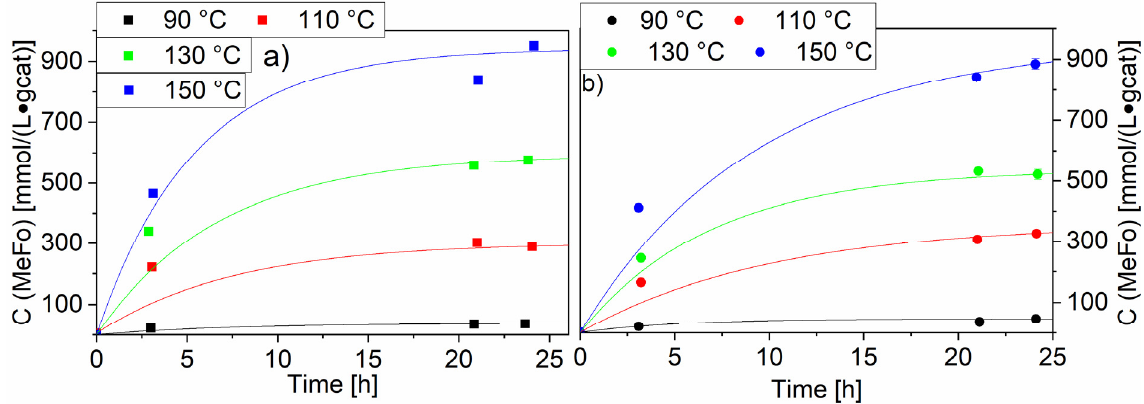
Figure 9. Impact of the temperature on the methyl formate productivity with Ru-NO-5-icr. and Ru-Cl-5-icr. used as catalysts. Graph ( a ) shows the MeFo concentration for the Ru-NO-5-icr. Catalysts, Graph ( b ) shows the methylformate concentration for the Ru-Cl-5-icr. catalyst. Testing conditions: 80 bar, CO:H 2 1:3, 50 mL methanol, quantification: GC-FID (PolyArc).